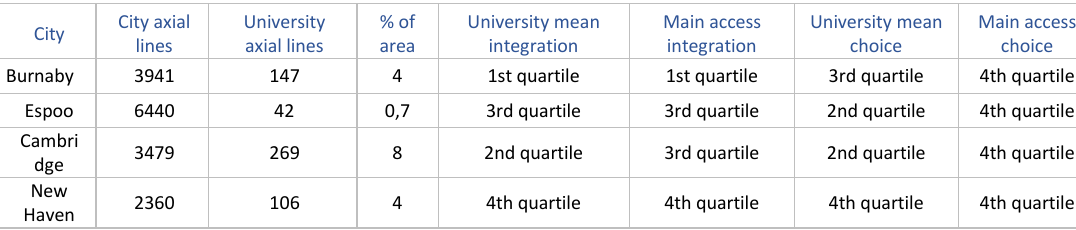
Table 2 Axial analysis